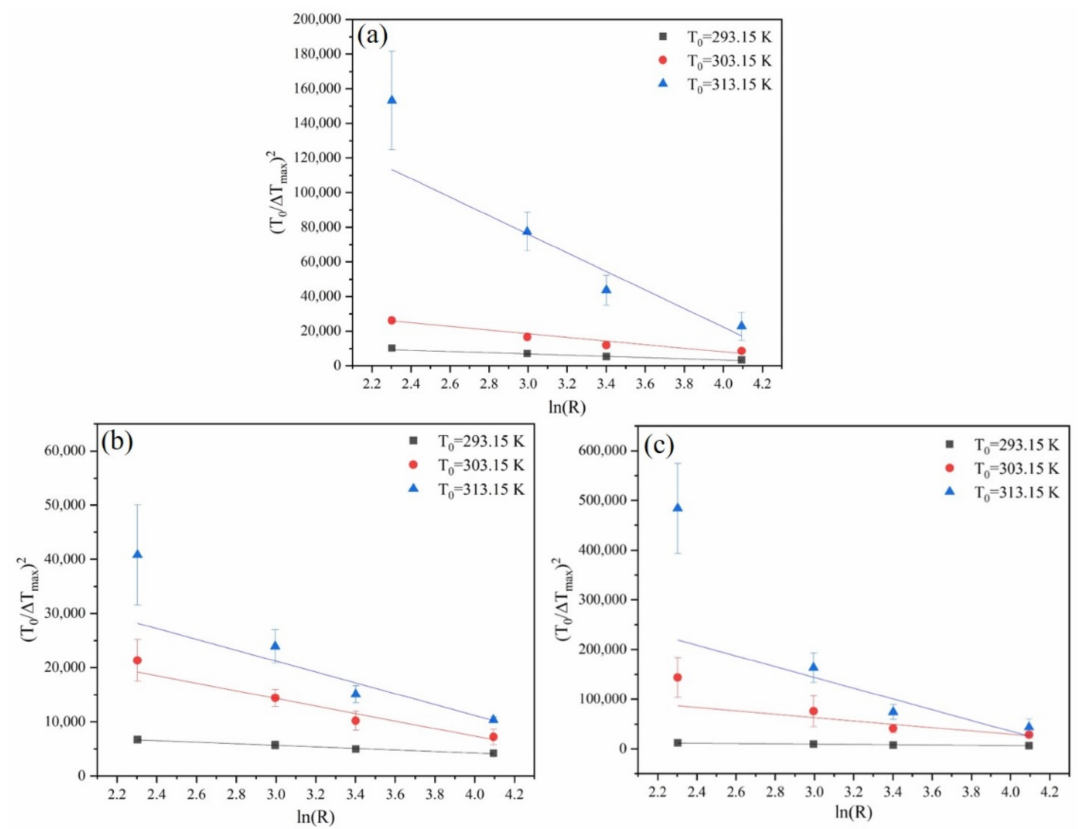
Figure 7. Relationship between MSZW and cooling rate at different saturation temperatures fitted by the Sangwal model: ( a ) ethanol mass fraction of 0.6, ( b ) ethanol mass fraction of 0.8, and ( c ) ethanol mass fraction of 1.0.